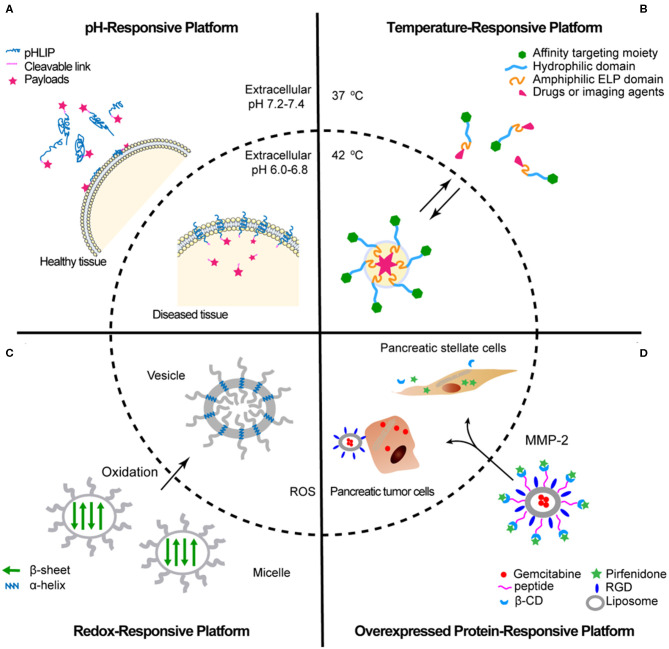
Schematic representations of peptide in response to the acidic pH (A), high temperature (B), the high oxidative potential (C), and the overexpressed protein MMP-2 (D).